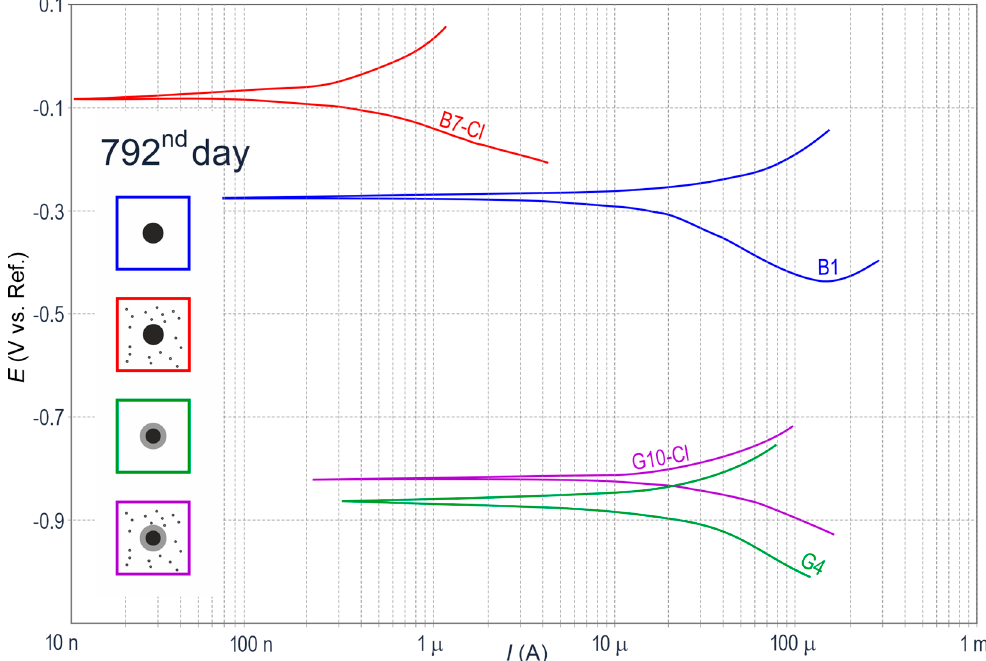
Figure 5. Potentiodynamic polarization curves for the steel reinforcement in concrete from four specimens on day 792, directly before microscopic tests: B1 —black steel in concrete without additives, G4 —galvanized steel in concrete without additives, B7-Cl —black steel in concrete with chlorides, and G10-Cl —galvanized steel in concrete with chlorides.